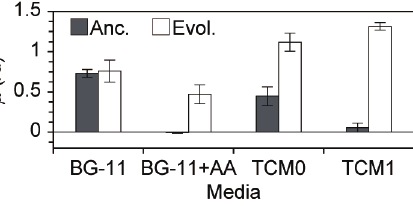
Figure 2. Specific growth rates of the ancestral and evolved cells in various environments. The black and white bars indicate the specific growth rates of the ancestral and evolved (at 408 days, 85 transfers, 548 generations) cells, respectively, in the culture media shown at the bottom. The error bars show the SD of five (for BG-11 and TCM1) or two (for the other media) independent cultures. The ancestral culture in BG11 + AA showed almost zero growth.